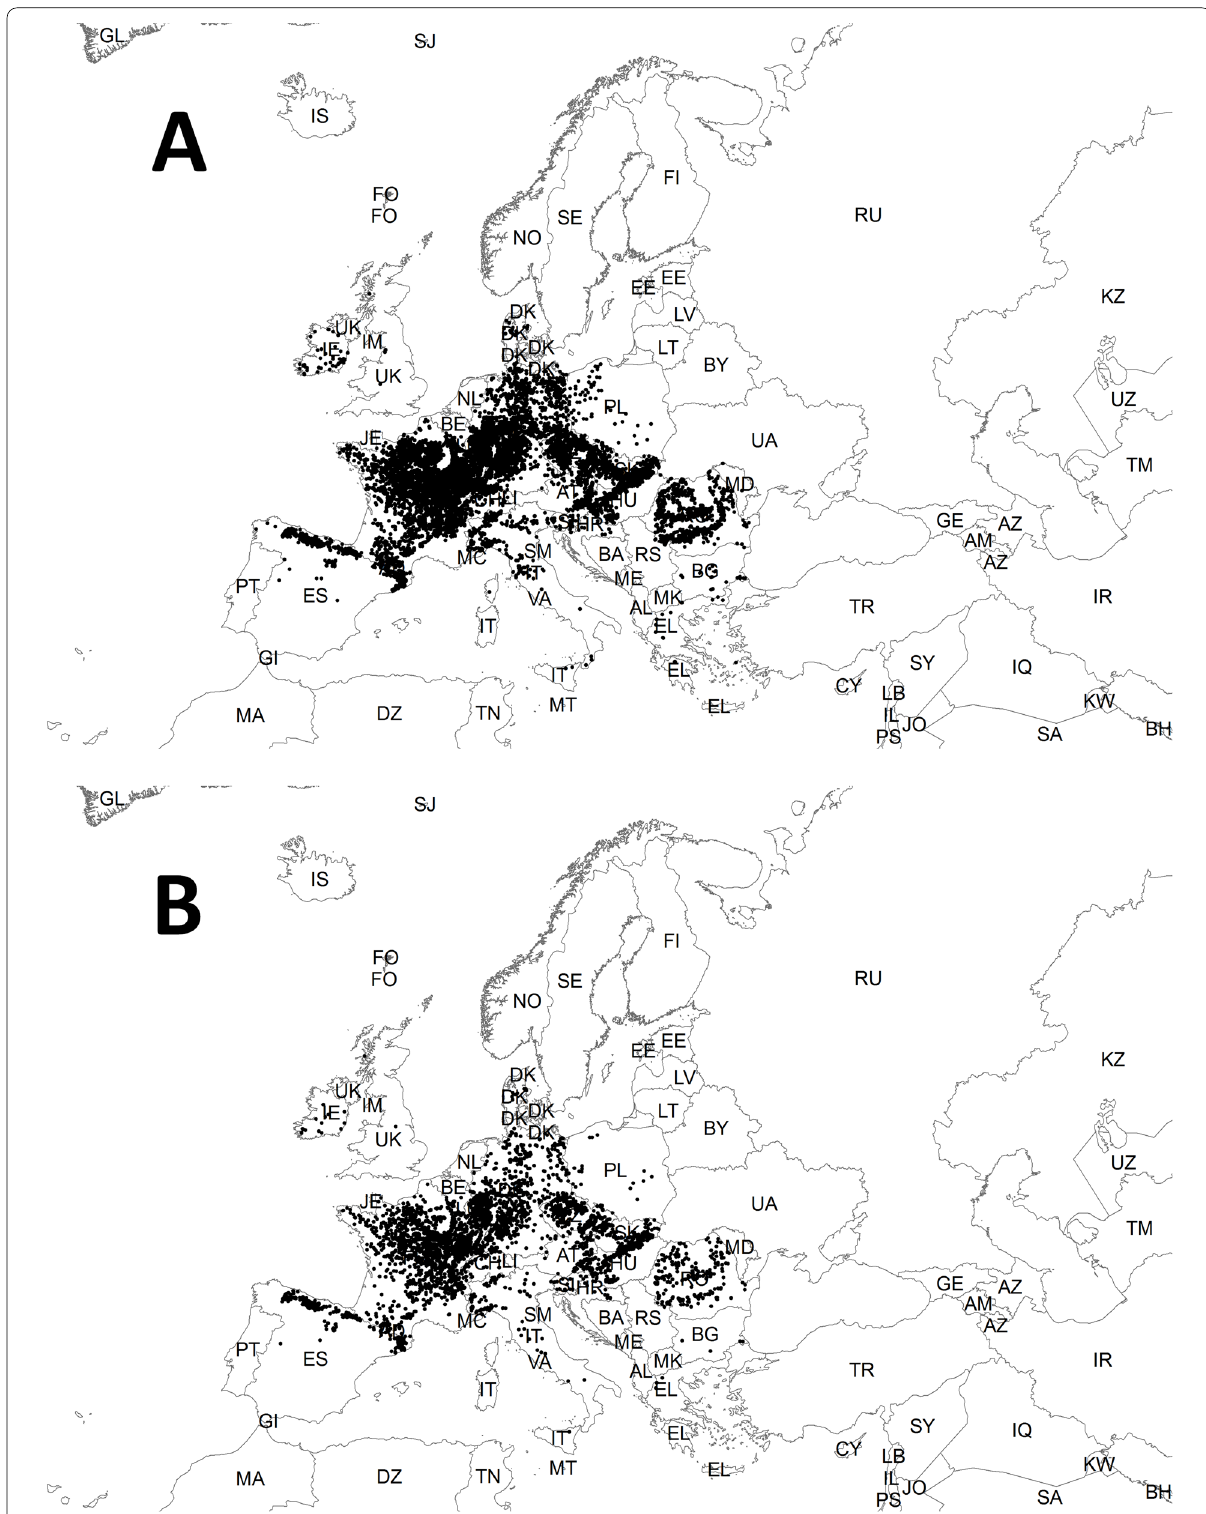
Fig. 1 Selected training ( A ) and test ( B ) samples of Quercus petraea, Liebl. from the European species distribution